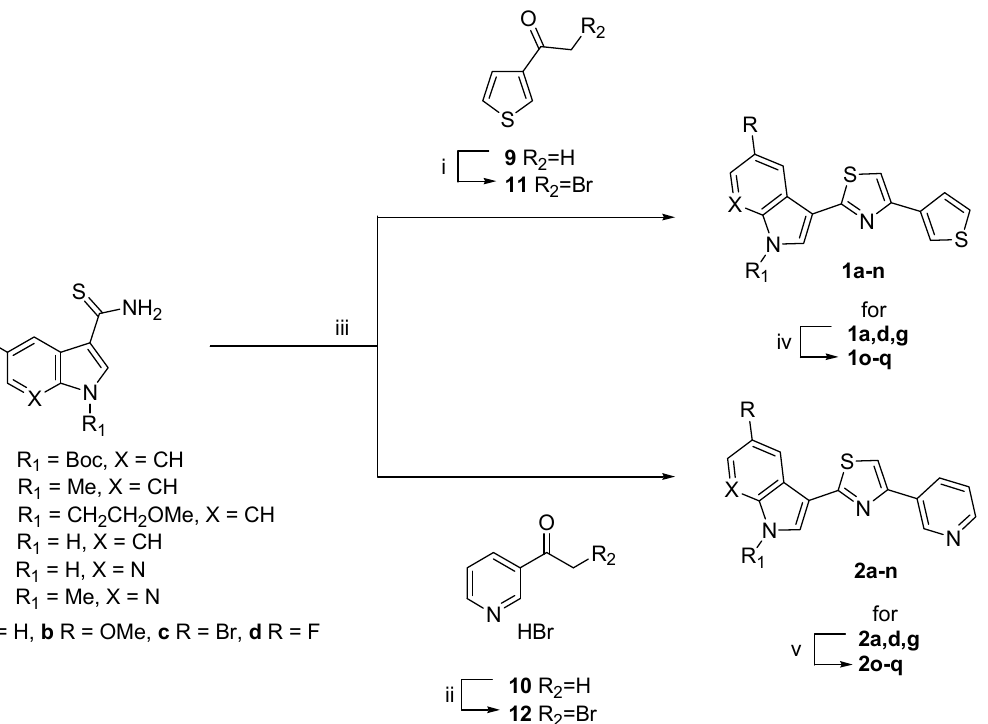
CH Table 2. Substituted 3-[4-(pyridin-3-yl)-1,3-thiazol-2-yl]-1 H -indole hydrobromides 2a–q . S N NX R 1